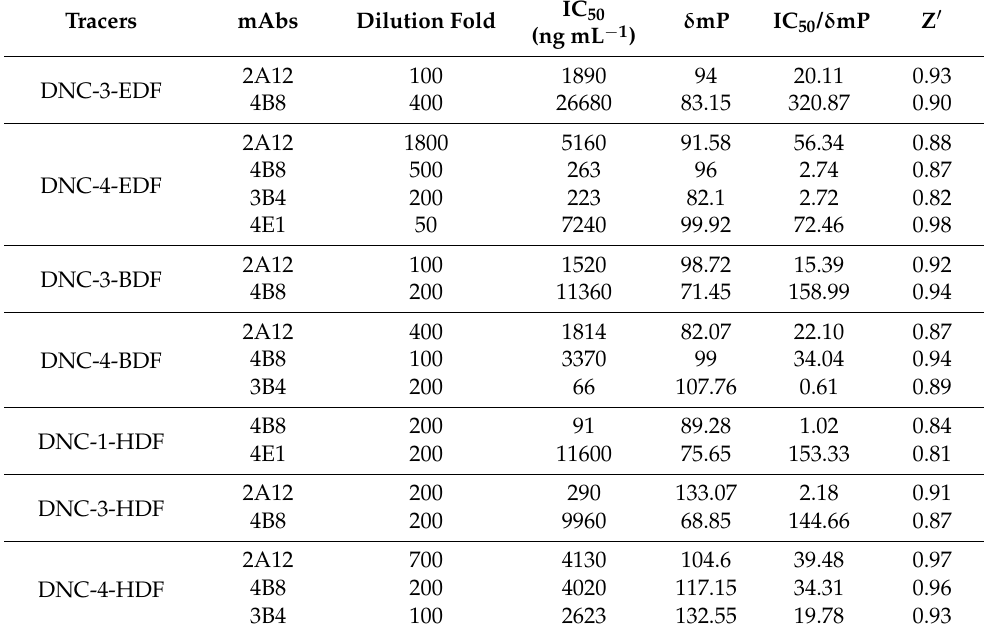
Table 1. Analytical parameters of the standard curves were obtained using four anti-NIC mAbs with seven DNC tracers. Tracers mAbs Dilution Fold